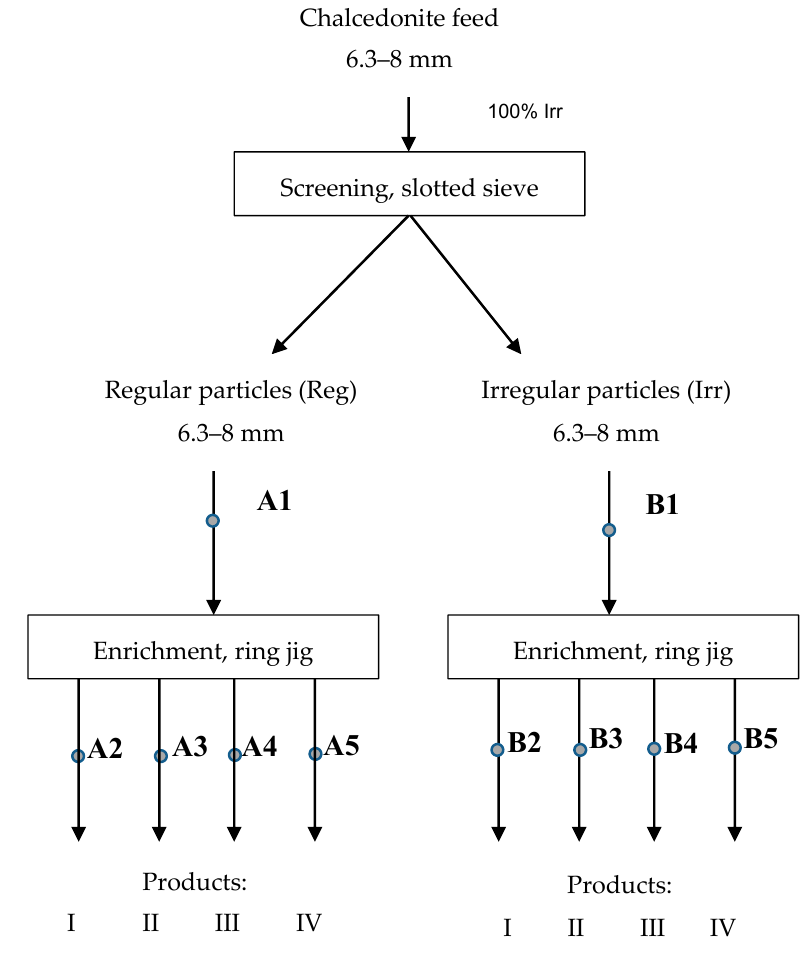
Figure 3. Scheme of investigations.